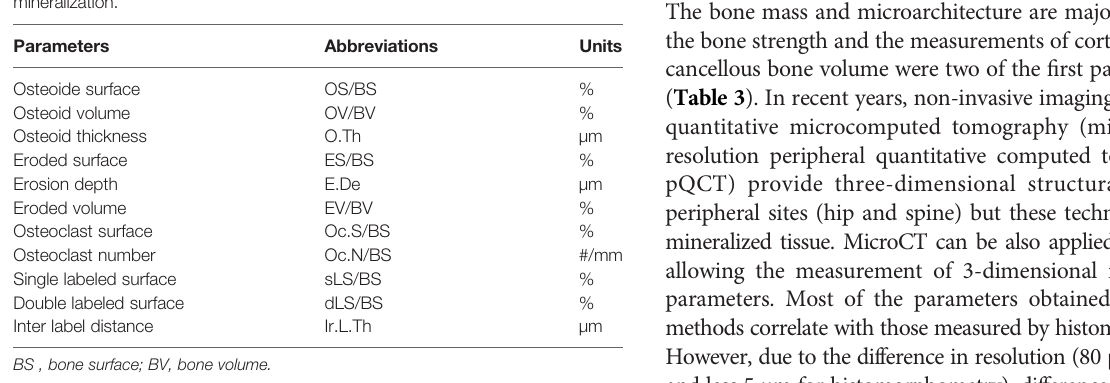
TABLE 1 | Measured parameters re fl ecting the bone remodeling and mineralization.